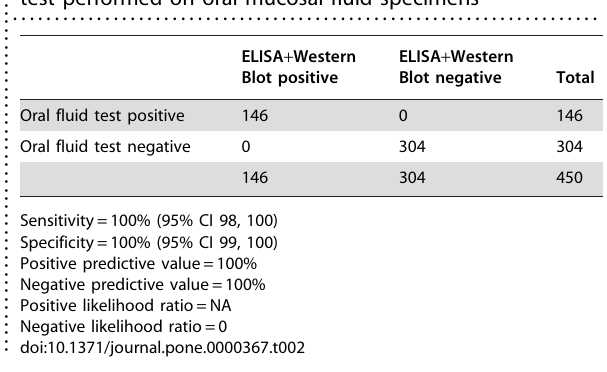
Table 2. Diagnostic accuracy of the OraQuick HIV-1/2 rapid